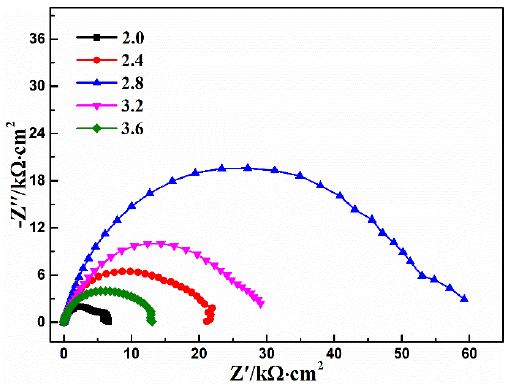
Figure 6. Experimental Nyquist plots of conversion coatings obtained from different pH values of Ca-P solution.